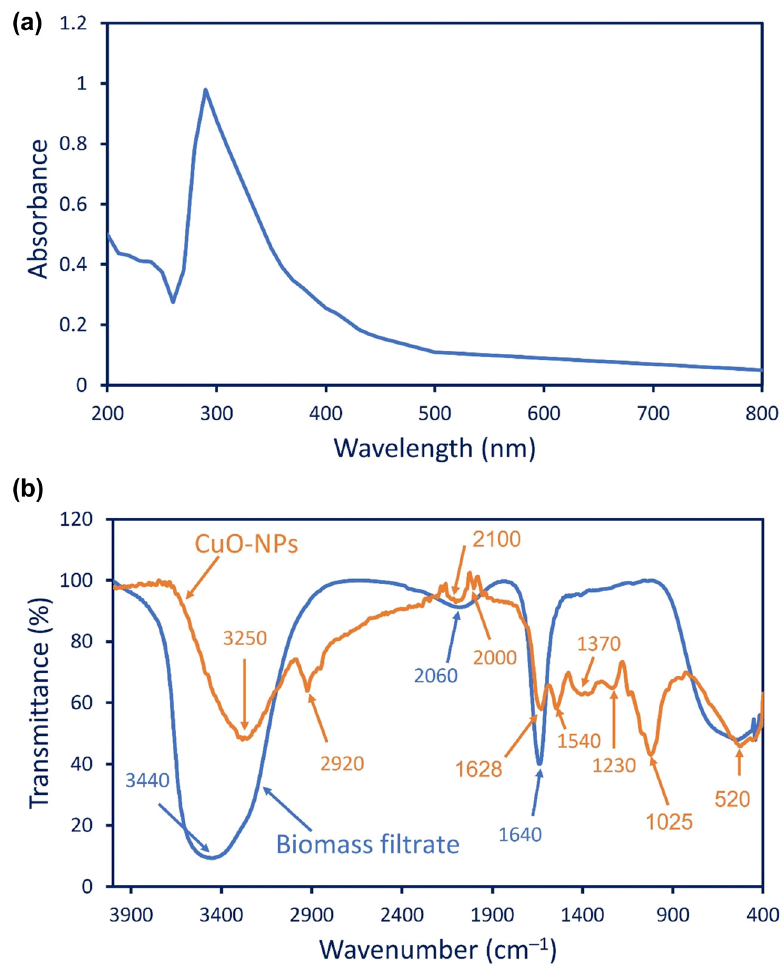
Figure 1: ( a ) UV - Vis spectroscopy showed the maximum SPR of bacterial - synthesized CuO - NPs at 290 nm and ( b ) FTIR of endophytic bacterial biomass fi ltrate and fabricated CuO - NPs showed various functional